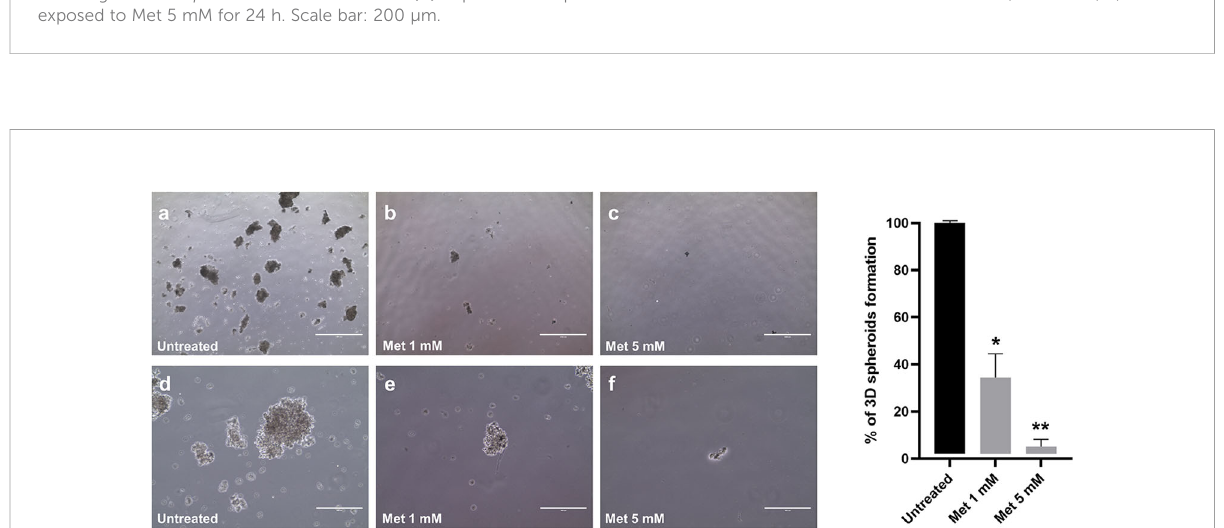
FIGURE 2 Dose-dependent effect of Met on 3D spheroid formation. Adherent SEM-1 cells were passaged to serum-free suspension media and tested for their ability to form 3D spheroids. Representative pictures: (A, D) untreated cells; (B, E) cells exposed to Met 1 mM for 14 days; (C, F) cells exposed to Met 5 mM for 14 days. Scale bars: 1000 µm (A-C) and 400 µm (D-F) . Histograms are representative of three replicates and express the mean 3D spheroids number (diameter > 50 µm) divided by the number of cells seeded relative to untreated controls. * p < 0.05 vs untreated cells (black bar), ** p < 0.05 vs cells treated with 1 mM Met (grey bar).